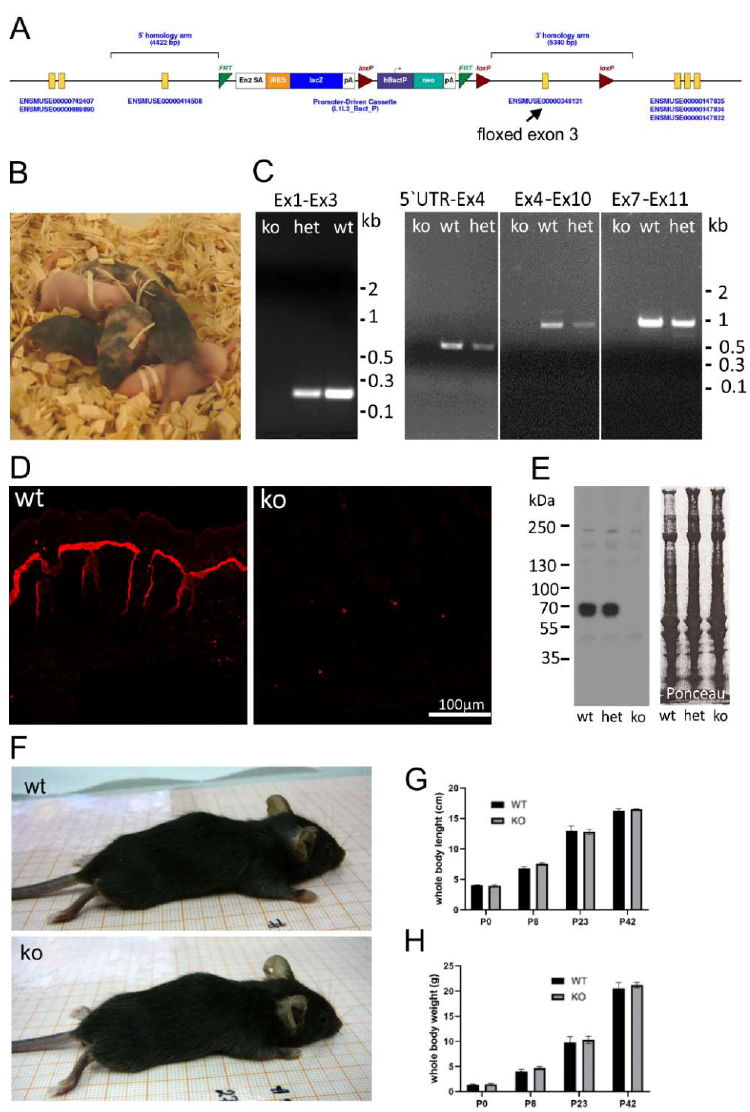
Figure 1. AMACO-deficient mouse model. ( A ) The targeting construct transfected into embryonic stem cells, contained exon 3 flanked by two loxP sites. En2 SA—engrailed 2 splicing acceptor; IRES—internal ribosome entry site; lacZ—β-galactosidase gene; pA—poly A; hbactP—human beta actin promoter; neo—promoter-driven neomycin resistance gene; FRT—flippase recognition target; Loxp—locus of crossover in p1. Modified from the KOMP consortium. ( B ) Five chimeric mice, obtained after successful injection of ES cells into a foster mouse. ( C ) RT-PCR on mRNA, showing the lack of transcribed message of the AMACO gene after successful deletion of the exon 3 gene with a Cre deleter mouse. Primers were designed to amplify different mRNA fragments because amplification of the full fragment was not successful. Ex1–Ex3, 5 (cid:48) UTR-Ex4, Ex4–Ex10, and Ex7–Ex11, correspond to bands of 190 bp, 530 bp, 1040 bp, and 1090 bp, respectively (Ex—exon; het—heterozygous). ( D ) Immunofluorescence analysis of newborn mouse skin showed a complete lack of AMACO in knockout mice. ( E ) Further characterization of the AMACO-knockout skin by immunoblot analysis showed a complete lack of AMACO expression. The blot is overexposed, to unequivocally show the absence of AMACO in knockout animals. Therefore, a possible difference between WT and het cannot be seen. Ponceau staining showed equal loading. ( F ) Physical observation of knockout mice compared to wildtype controls showed no obvious phenotype. Whole body weight ( G ) and length ( H ) recording from birth until adulthood revealed no significant alteration compared to the wildtype controls. n = 5 (P—postnatal